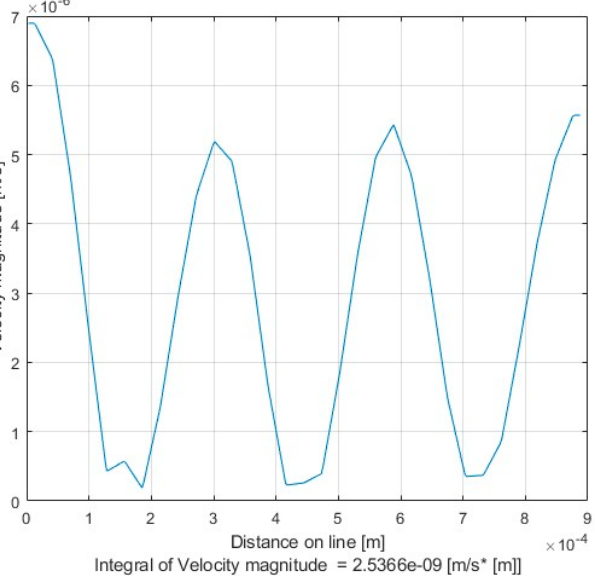
Figure 21. Plot of the velocity distribution in the middle of the channel and across the electrode region.